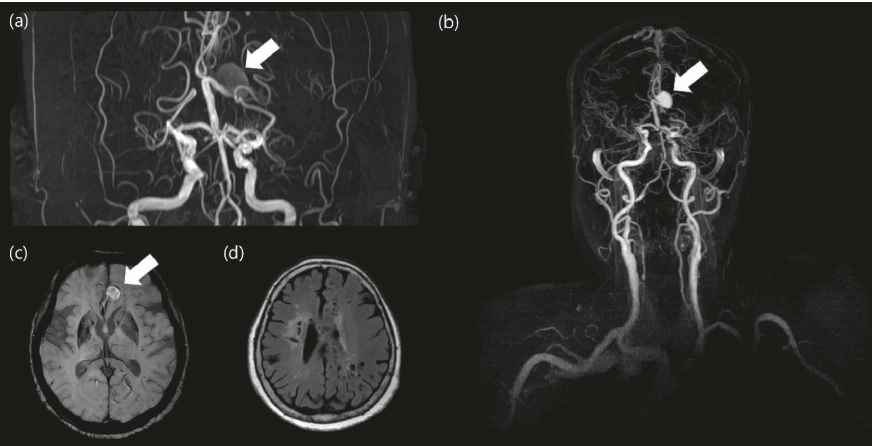
Figure 1: The brain MR images in moyamoya disease patients with a large intracranial aneurysm. (a) Brain TOF-MRA presenting a bilateral middle cerebral artery occlusion with a large aneurysm (arrow). (b) Brain MRA with gadolinium enhancement in the same patient with a large aneurysm (arrow). (c) SWI image presenting with large intracranial aneurysms (arrow). (d) FLAIR image showing multiple old ischemic lesions in the